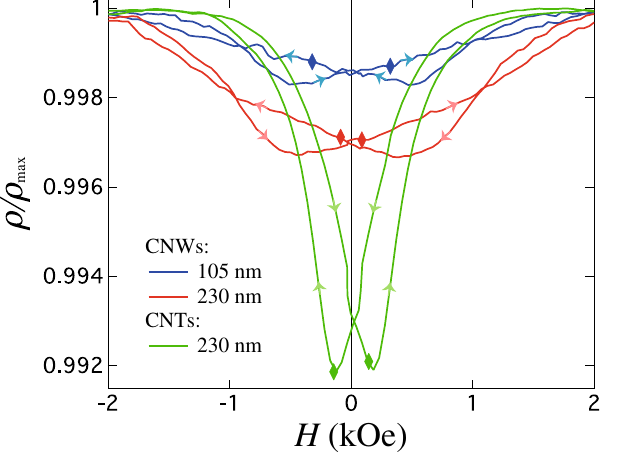
Figure 6. AMR curves recorded in the OOP direction for CNW networks with NW diameters of 105 nm and 230 nm and for a CNT network with outer diameter of 230 nm. The arrows indicate the magnetic field sweep direction from positive to negative or from negative to positive. The lozenges indicate the resistance states at the corresponding coercive field for each